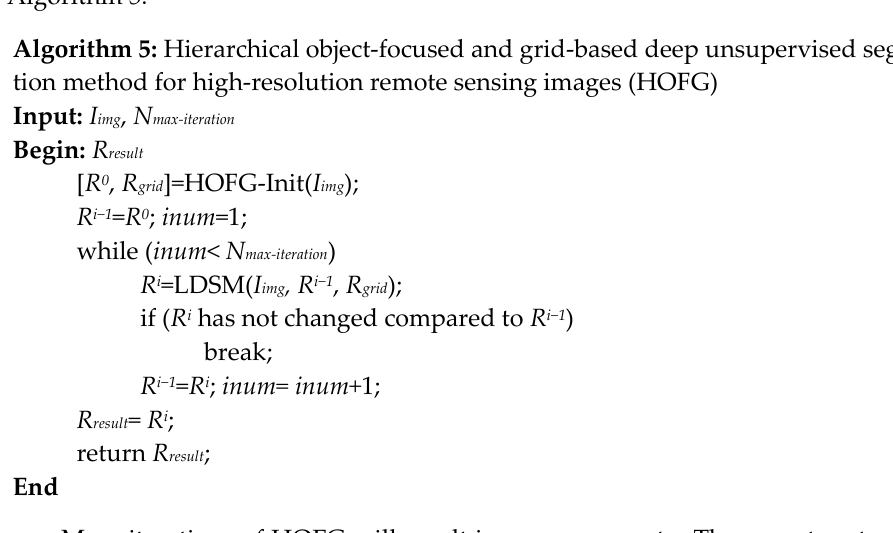
Algorithm 5: Hierarchical object ‐ focused and grid ‐ based deep unsupervised segmenta ‐ tion method for high ‐ resolution remote sensing images (HOFG)